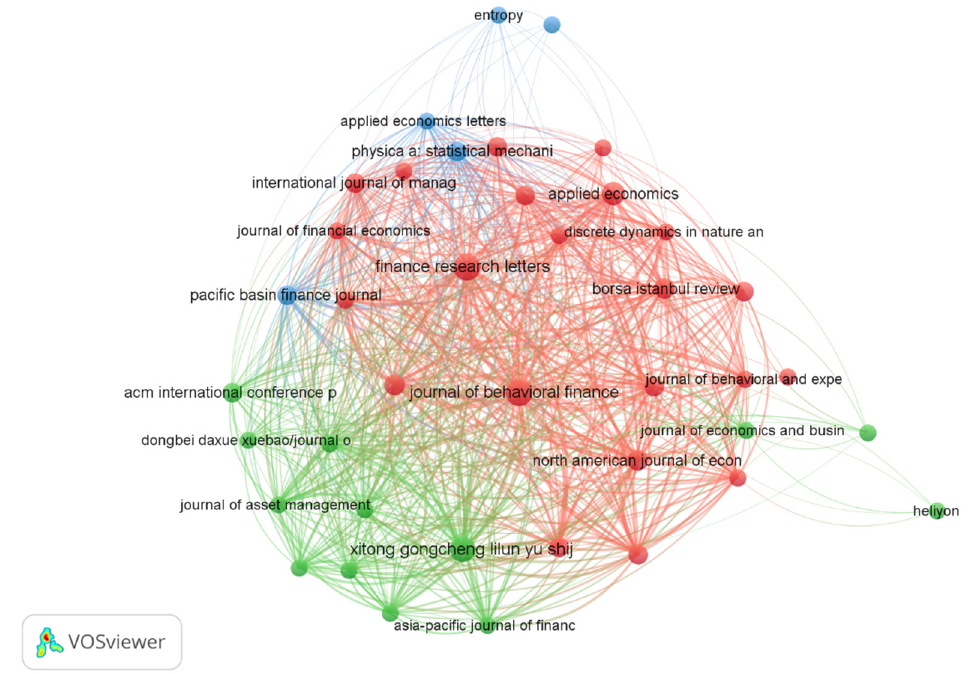
Figure 6. Most relevant sources.